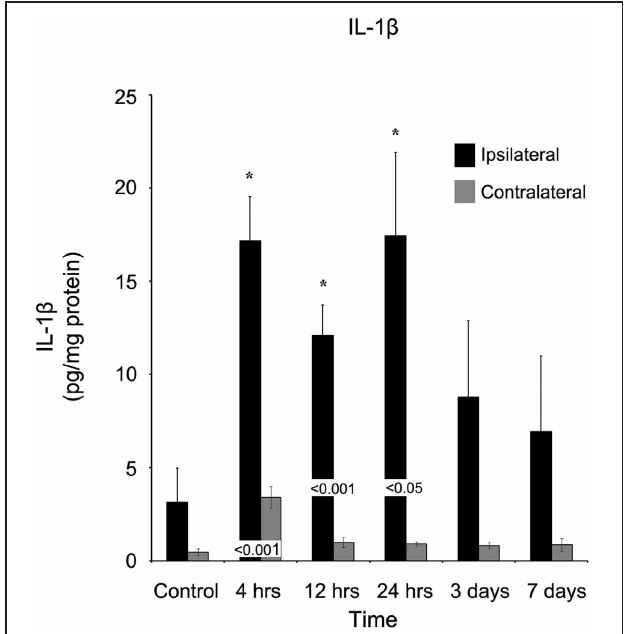
FIGURE 9 | IL-5 concentrations in the ipsilateral and contralateral cortex were not affected by a controlled cortical impact. At no time point after the brain injury were elevated concentrations of IL-5 observed in either the ipsilateral or contralateral cortex in comparison to control tissue ( p > 0 . 05). All values are mean ± SEM, n =